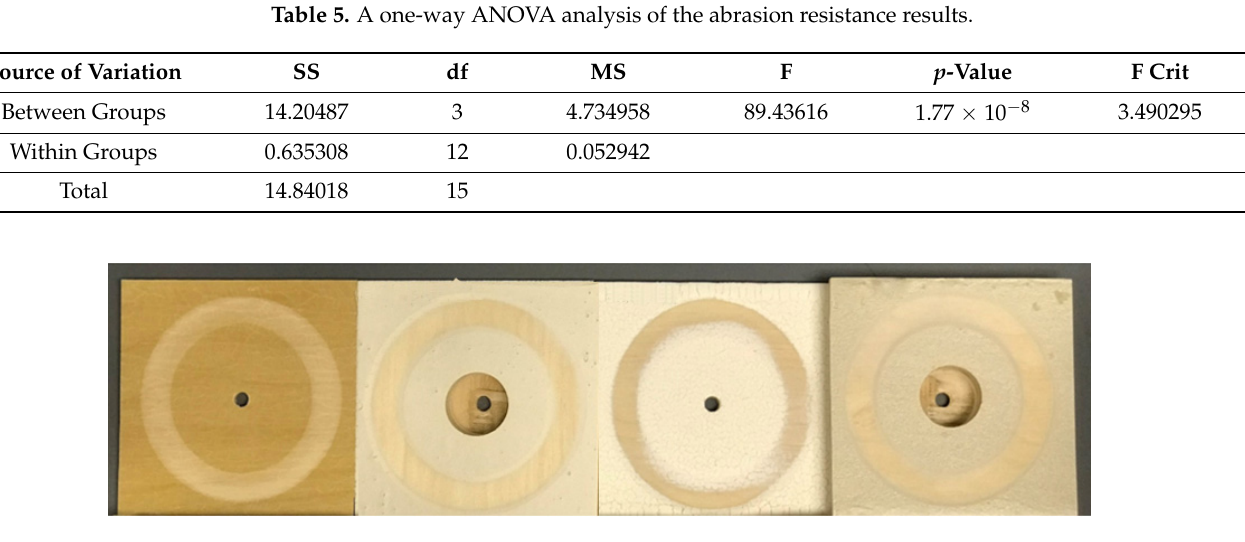
Figure 8. Images of the tested plywood specimens using the Taber Abrader, from left: casein; casein–ATH–mica, casein–ATH and casein–mica.